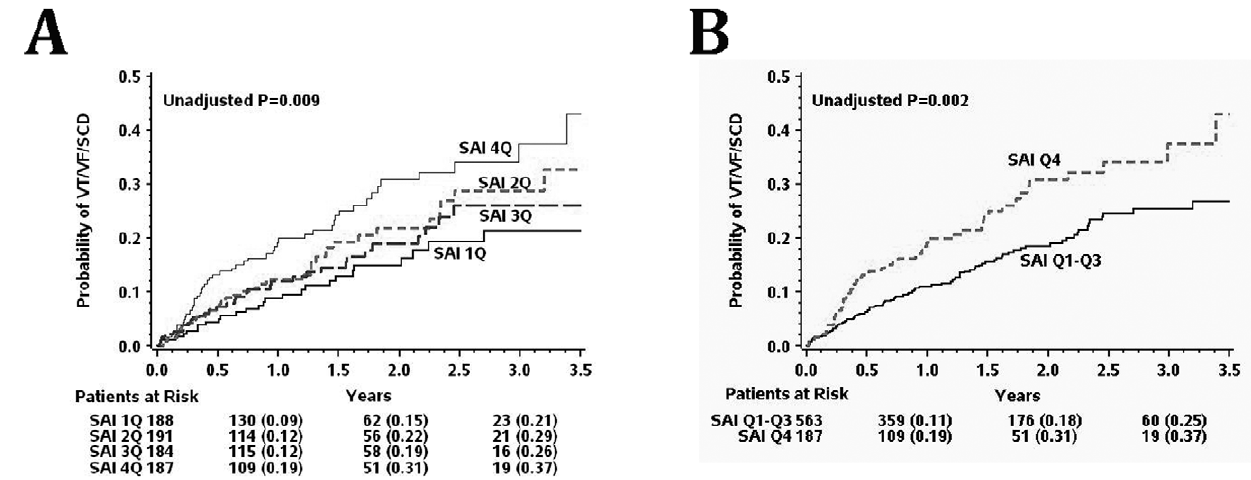
Figure 3. Kaplan-Meier curves for the probability of sudden arrhythmic death, (A) by quartiles of SAI QRST; (B) in patients with the highest SAI QRST quartile and those with the lower 3 SAI QRST